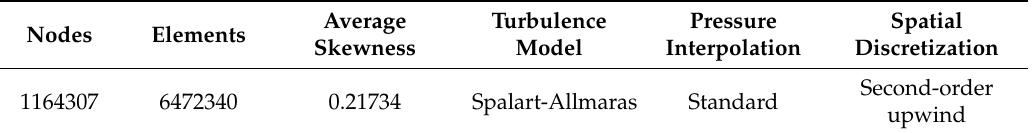
Table 1. Mesh parameters.